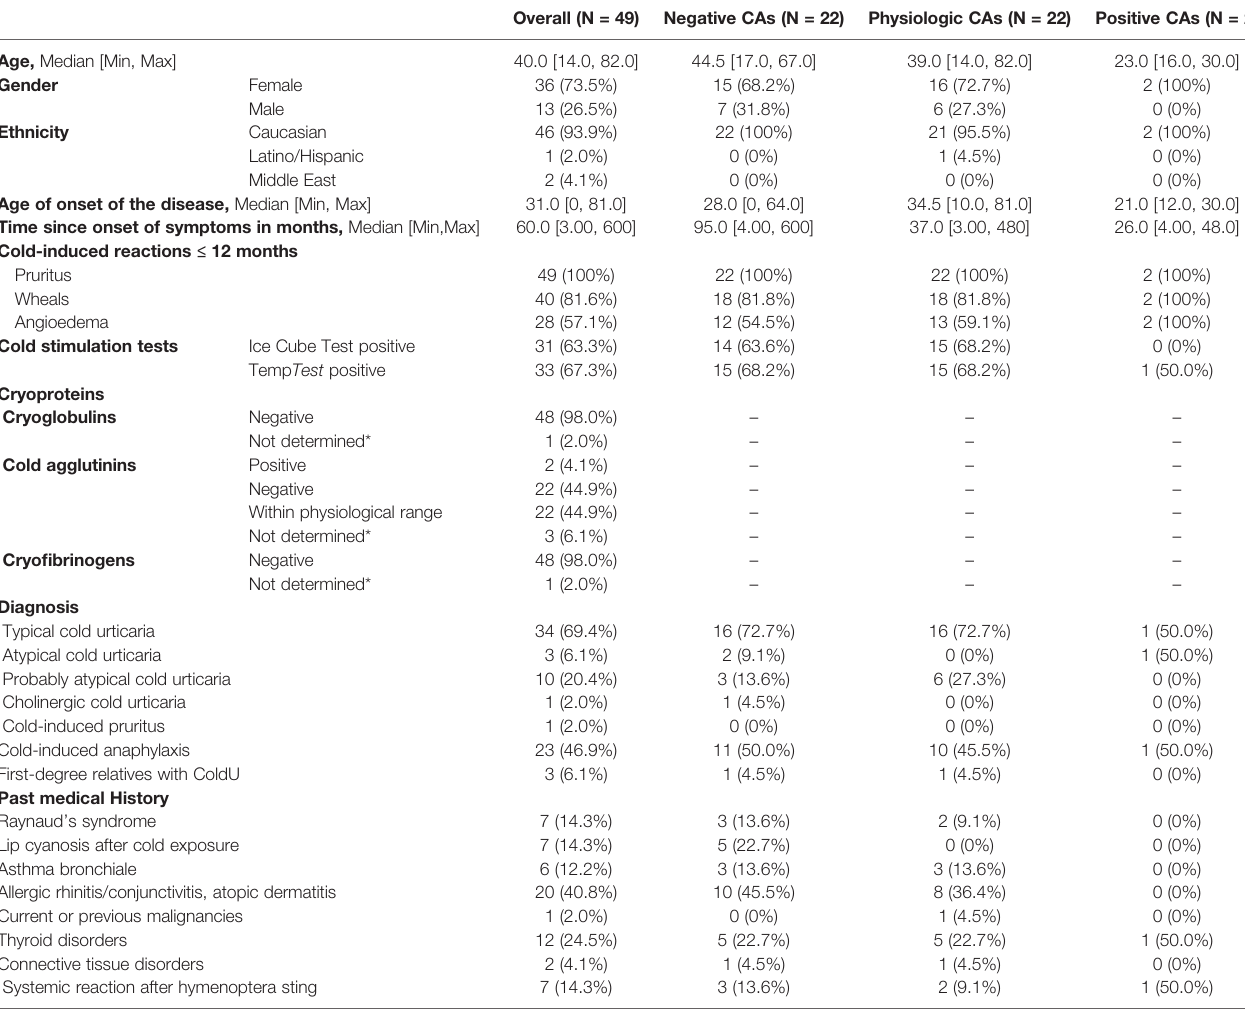
*Sample not suited for analysis. N, number of patients; CAs, Cold